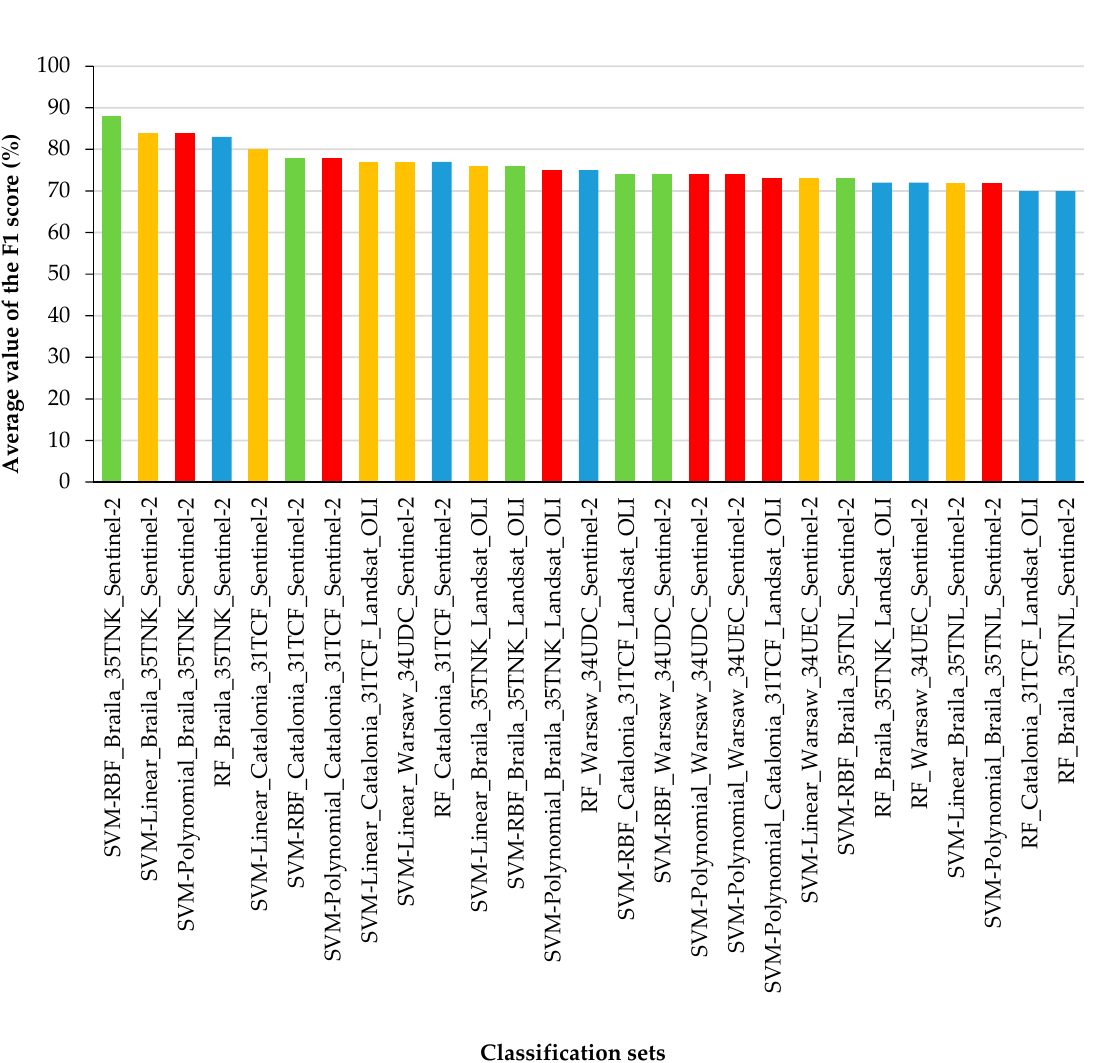
Figure 7. The best classification results from used different datasets and algorithms (Green boxes mean Support Vector Machines (SVM) Radial Basis Function kernel, orange—SVM linear kernel function, red—SVM polynomial kernel function, blue—Random Forest (RF) classifier).